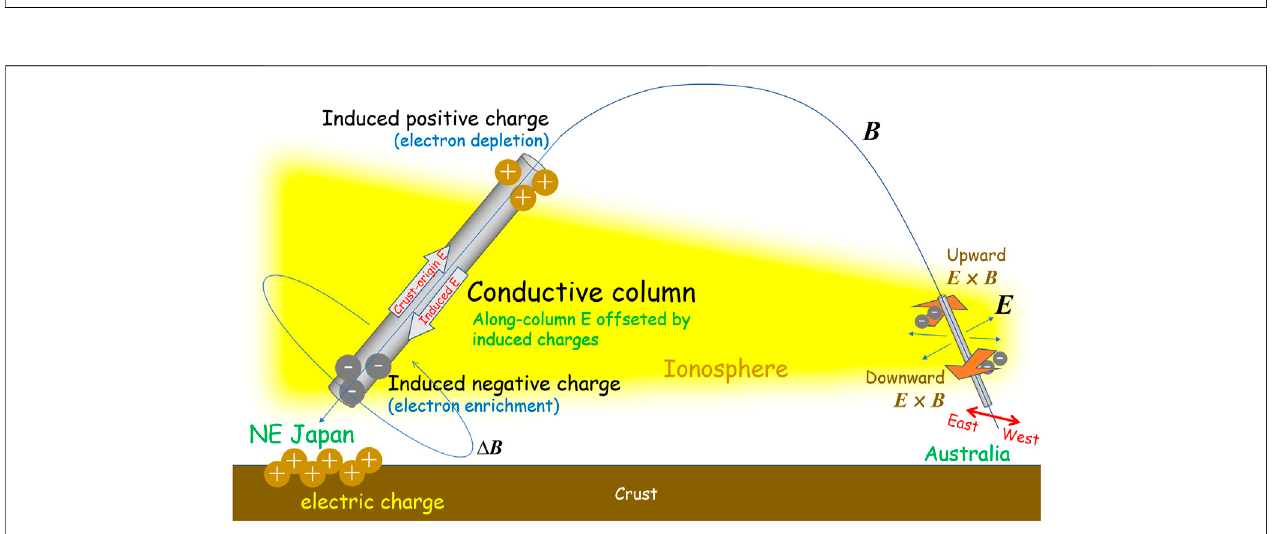
FIGURE 8 | Image of the electron redistribution above the epicenter and its CP.